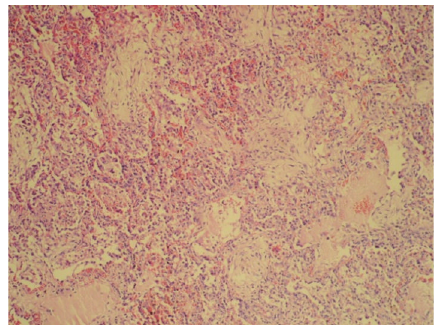
Figure 2: Alveolar organizing fibrosis, H&E, × 100.